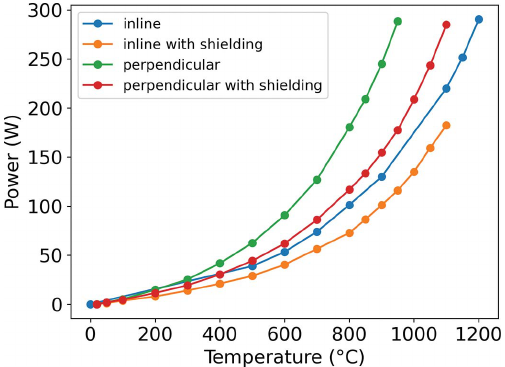
Figure 4 Plot of temperature against power consumption with the in-line and perpendicular designs, with and without radiation